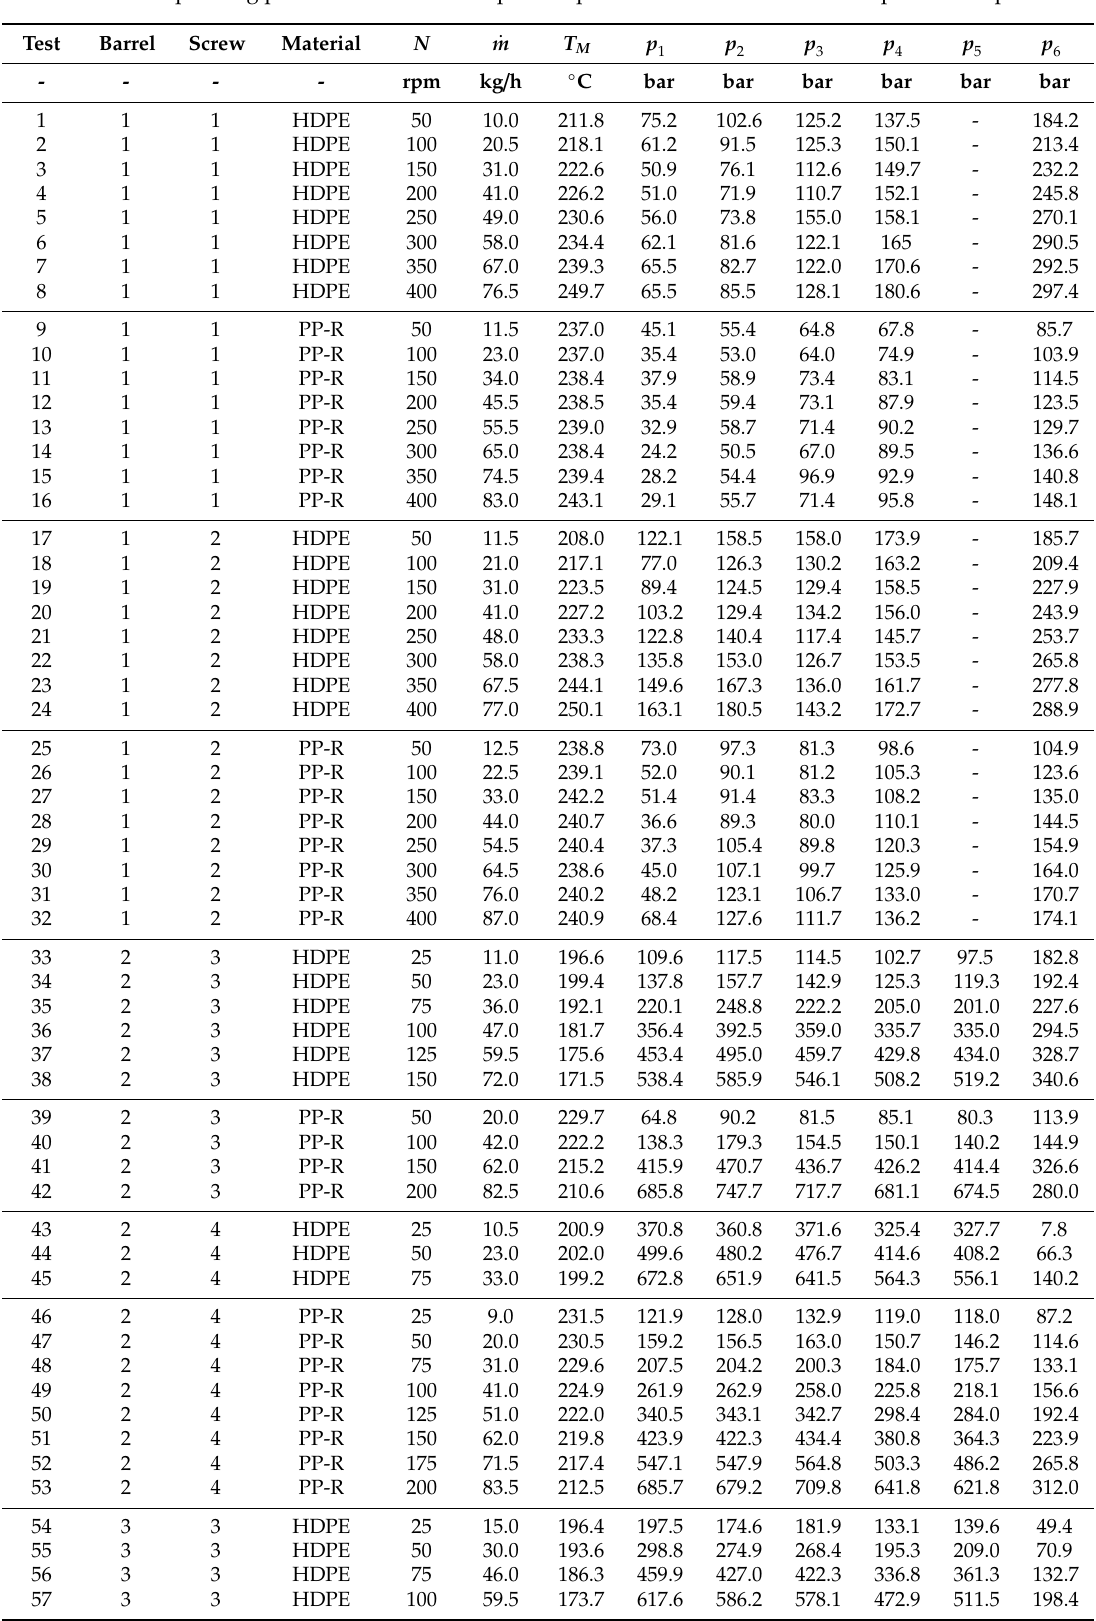
Table A1. Operating points. Mean values of process parameters measured in the experimental